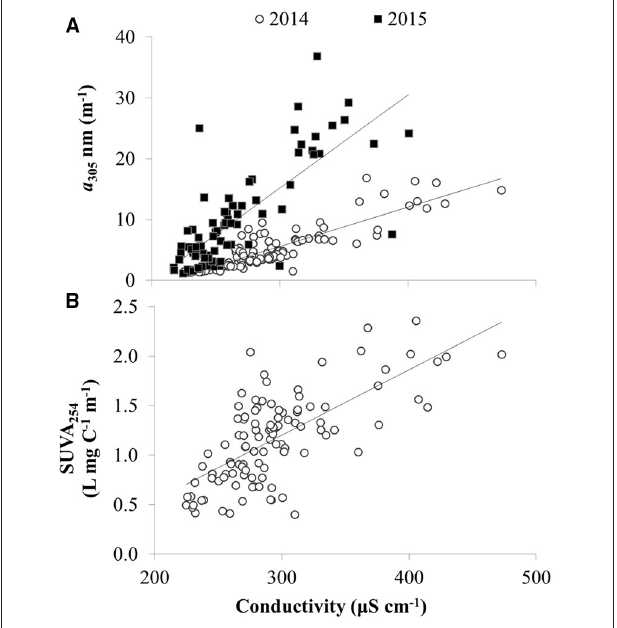
FIGURE 5 | CDOM concentration and composition vs. specific conductivity in Lake Erie. (A) CDOM absorption coefficient at 305nm ( a 305 ) vs. specific conductivity in 2014 and 2015. (B) Specific UV absorbance at 254nm (SUVA 254 ) vs. conductivity in 2014 (DOC data not available for 2015). Lake water with higher specific conductivity is more influenced by river water, whereas lake water with lower specific conductivity is less influenced by river water. Lines show linear regression fit for slopes significantly different than zero ( p < 0.01